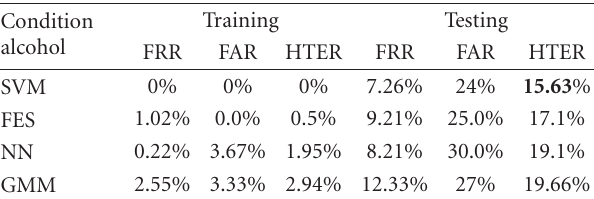
Table 3: Training and evaluation results for the detection of alcohol using all available features.